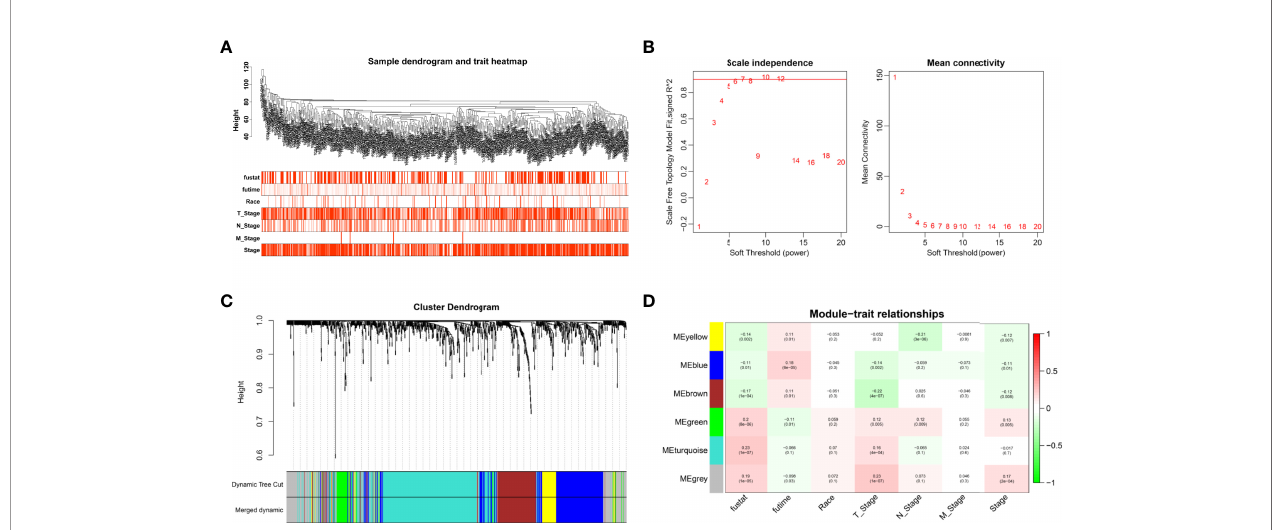
FIGURE 1 | Weighted co-expression network construction. (A) Dendrogram and trait heatmap for TSCC patients. (B) Network topology for different soft- thresholding powers. (C) A cluster dendrogram based on the dynamic tree cut algorithm. (D) Module – trait relationship visualization of co-expression modules and clinical